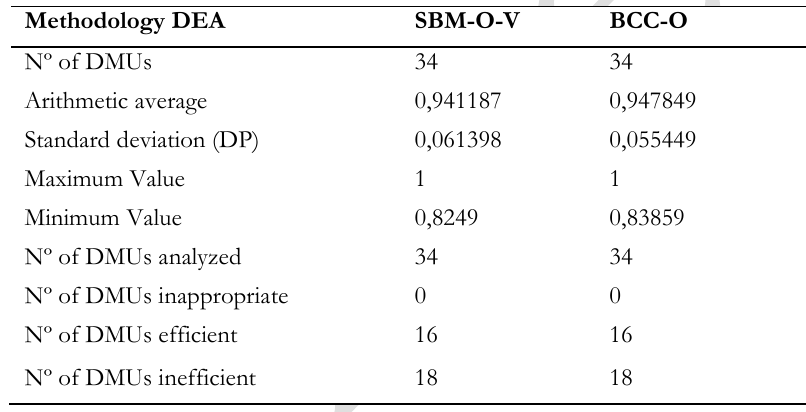
Table 1 – Analysis results of SBM – O-V and DEA BCC-O models.